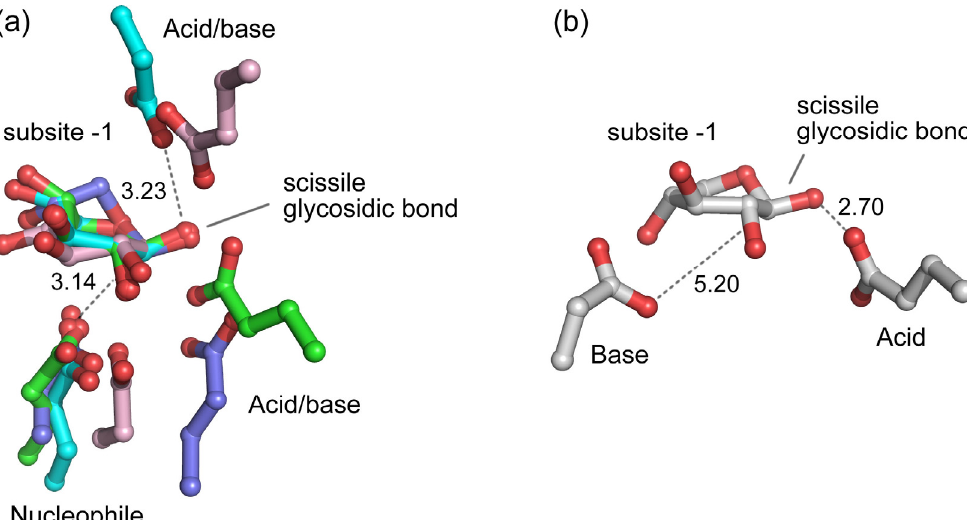
Figure 6. Positions of the catalytic residues relative to the xylosyl moiety bound in subsite -1 of the active sites of ( a ) retaining and ( b ) inverting β -xylosidases. The structures are of GlyA1 (PDB 5K6N; GH3; carbon atoms in pink), GsXynB1 (PDB 2BFG; GH39; green), GT2_24_00240 (PDB 4C1P; GH52; cyan), and TsXylC (PDB 3VSU; GH120; blue), which are retaining β -xylosidases, and GsXynB3 (PDB 2EXJ; GH43; white), which is an inverting β -xylosidase (see caption of Figure 3 for further details of the enzymes). Important distances (in Å) are shown next to dashed lines.